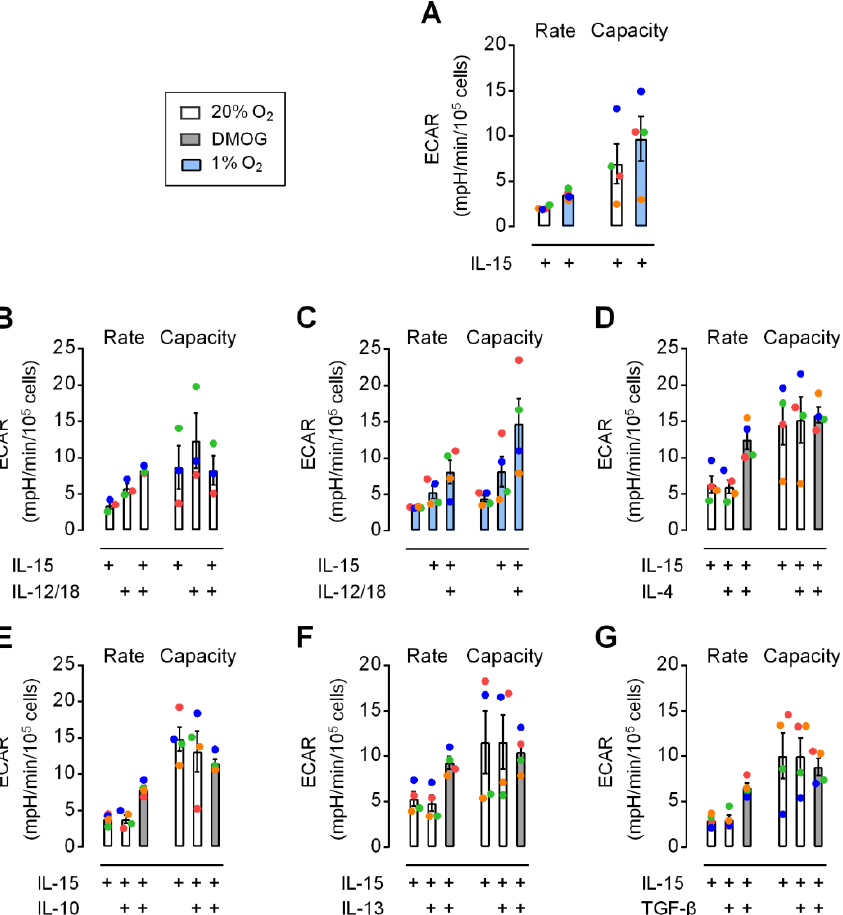
Figure 5. Hypoxia and IL-12/IL-18 moderately increase glycolysis in IL-15 primed human NK cells. NK cells from 3 or 4 donors were cultured for 16 h, IL-15 primed for 6 h and cultured for another 4 h in the additional presence of different cytokines as indicated. During both cytokine treatments and measurements of extracellular acidification rate (ECAR) values, cultures were kept under normoxia (20% O 2 , open bars), hypoxia (1% O 2 , blue bars) or chemical hypoxia (DMOG, gray bars). Panel ( A ) shows the effect of hypoxia and panel ( B ) and ( C ) the effect of IL-12 combined with IL-18 (IL-12/18) under normoxia and hypoxia, respectively. Alternative to IL-12/18, NK cells primed with IL-15 in the absence or presence of DMOG were treated with ( D ) IL-4, ( E ) IL-10, ( F ) IL-13 and ( G ) TGF- β . The level of statistical significance was not reached when applying the Friedman test with Dunn’s test for post-hoc pairwise comparisons.